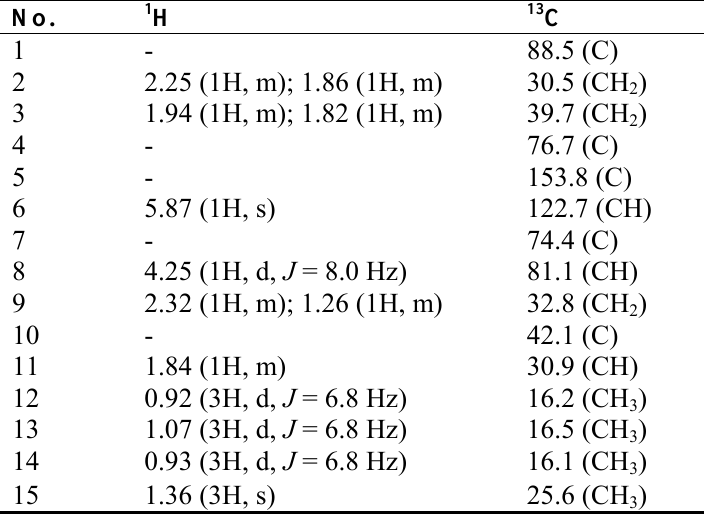
Table 1. 1 H- and 13 C-NMR spectra data of 1 (recorded at 400/100 MHz in CDCl ppm, J in Hz).